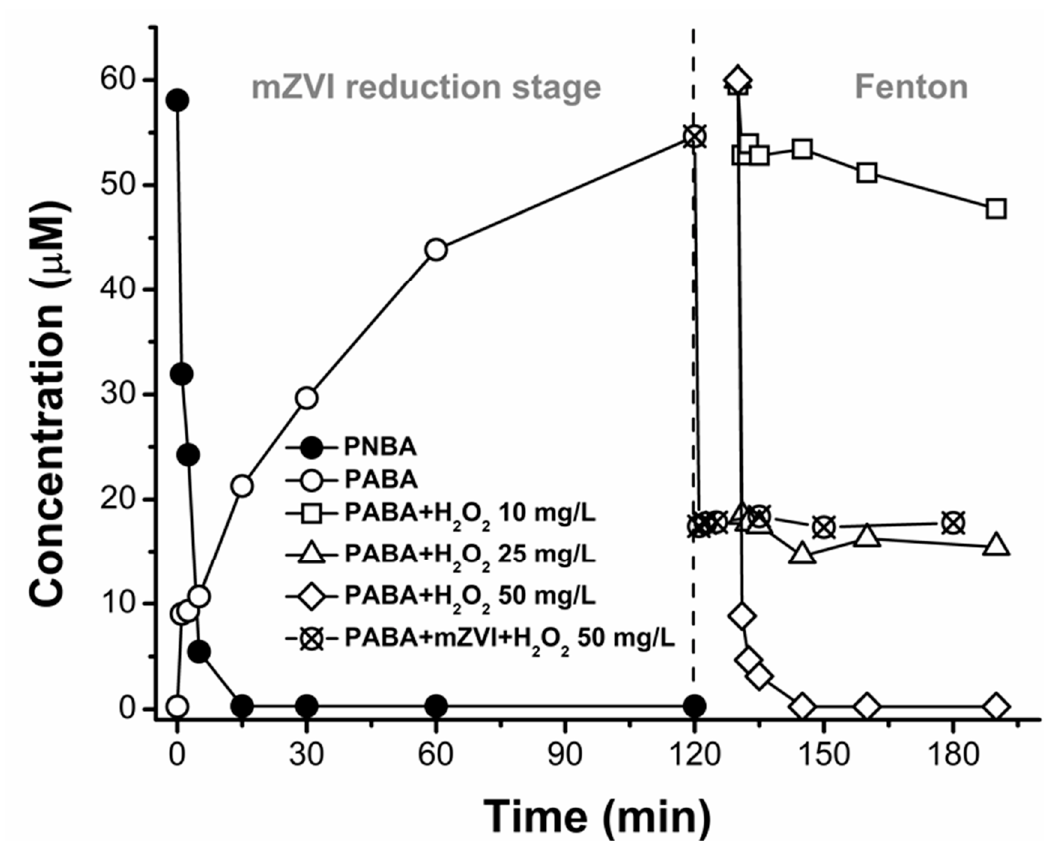
Figure 5. Reduction of PNBA 60 µM in NW at initial pH 3.0 with 1.4 g/L of mZVI, followed by the different tested Fenton oxidations. When needed, 10 min for mZVI separation took place.